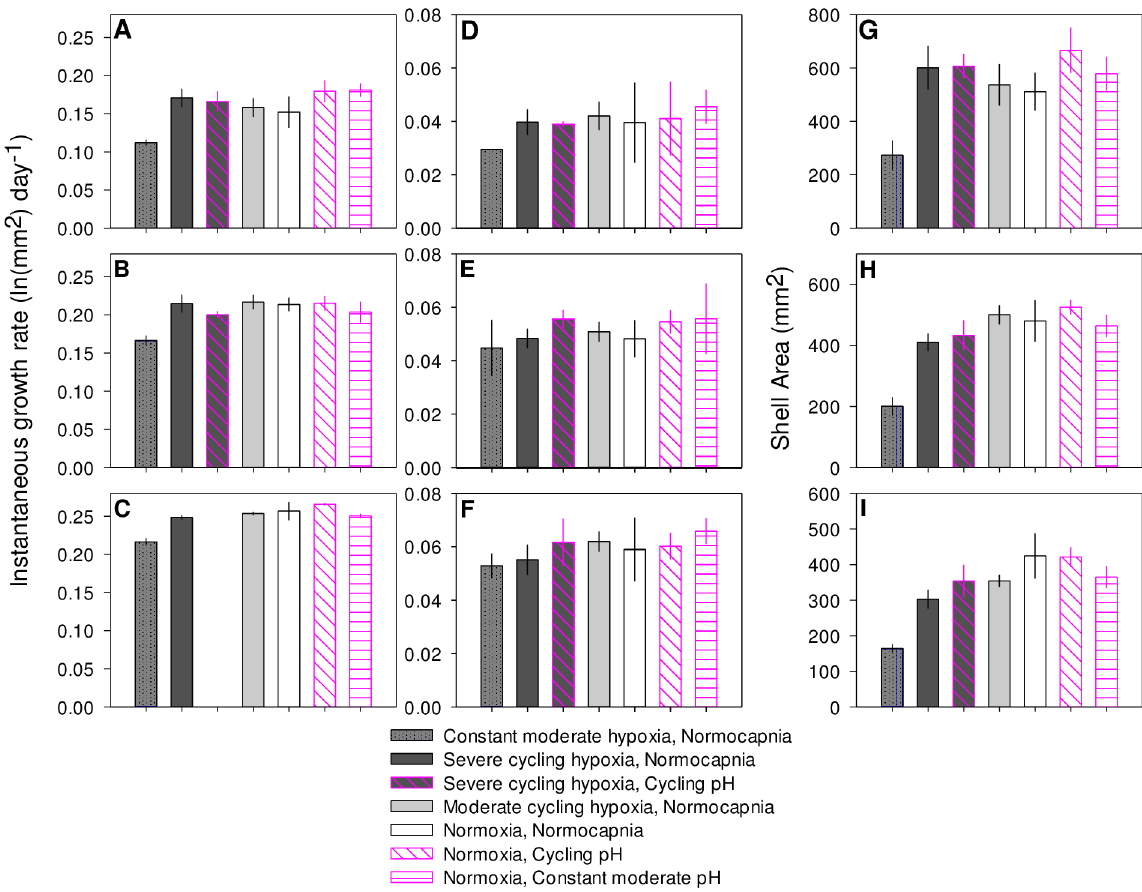
Fig 3. 2013 juvenile growth experiment. Mean ± 1 SE instantaneous rate of growth in shell area during first two weeks of the experiment for three age classes of juvenile oysters; (A) 4 weeks post-settlement cohort, (B) 2 weeks post-settlement cohort, and (C) 1 week post-settlement cohort. Mean ± 1 SE instantaneous rate of growth in shell area during second two weeks of the experiment for three age classes of juvenile oysters; (D) 4 weeks post-settlement cohort, (E) 2 weeks post-settlement cohort, and (F) 1 week post-settlement cohort. Mean ± 1 SE shell area of (G) 4 weeks post-settlement cohort, (H) 2 weeks post-settlement cohort, and (I) 1 week post-settlement cohort of juvenile oysters at the end of the month-long experimental exposure.